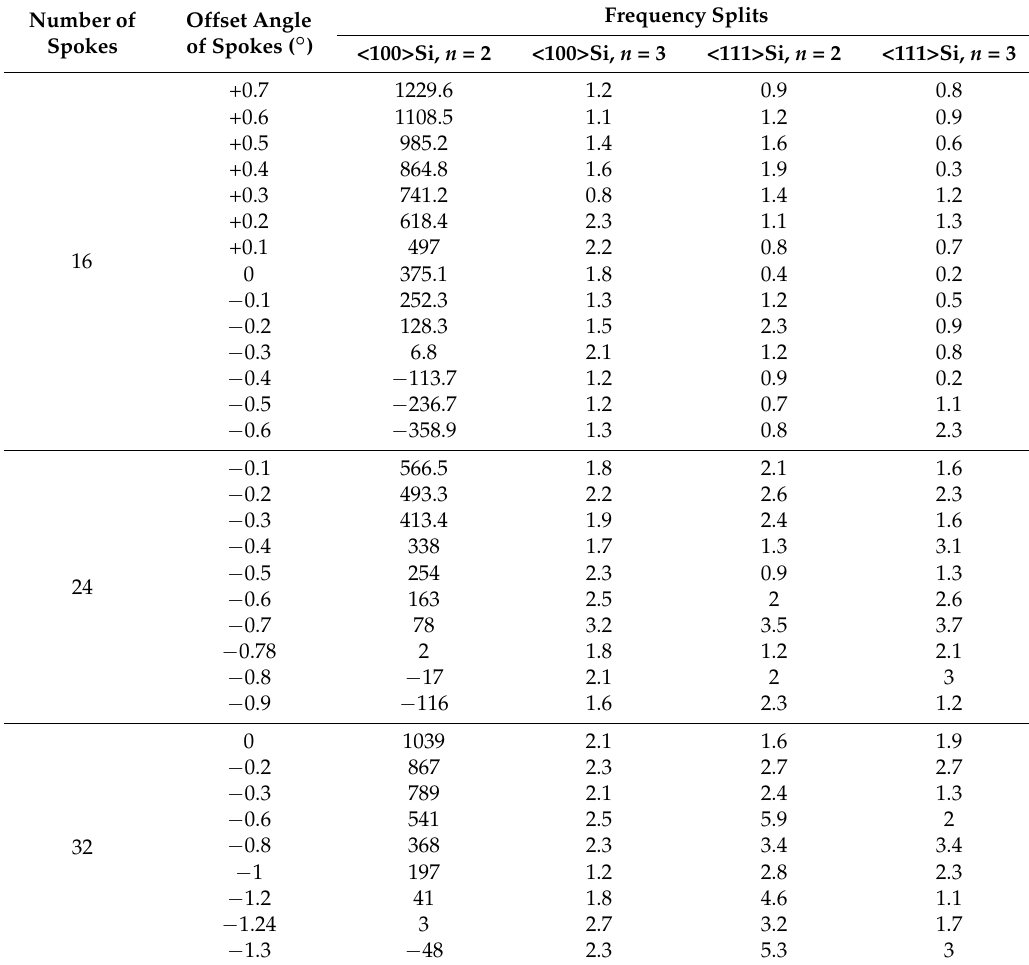
Table 1. The Results of Simulation of Frequency Splits in DRGs with different material, mode and spoke angular